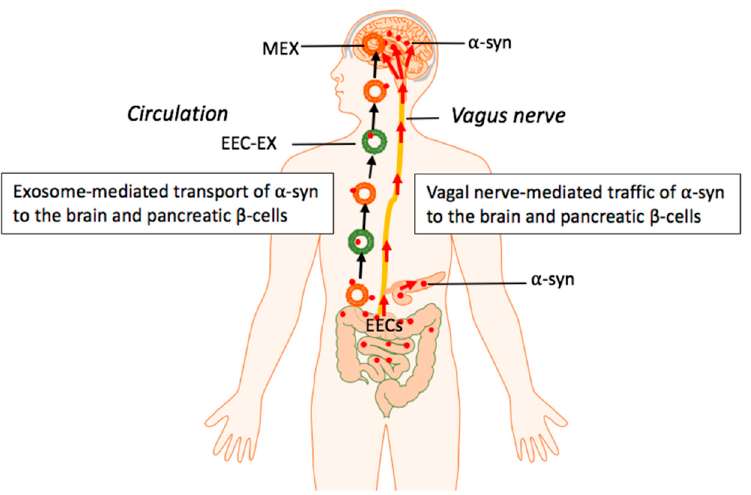
Figure 3. Hypothetical model: Milk exosome (MEX) miRNAs promote intestinal synthesis and impaired catabolism of α -syn with transmission of aggregated α -syn via the vagal nerve and systemic circulation of enteroendocrine cell (EEC)-derived exosomes as well as MEX that may reach both pancreatic β -cells and dopaminergic neurons of the brain.